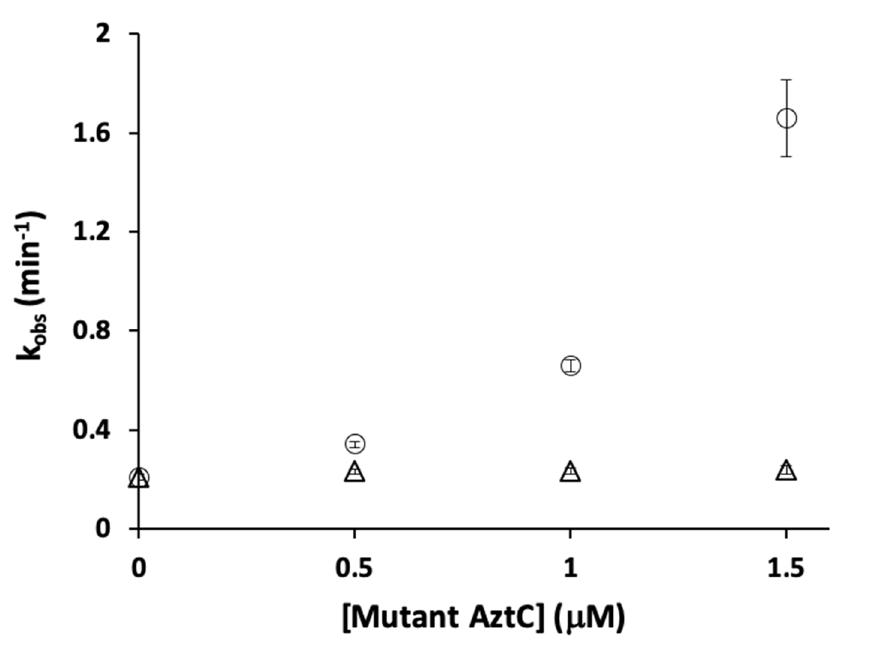
Figure 7. Kinetics of zinc transfer from WT AztD to WT AztC in the presence of mutant AztC. Observed first order rate constant versus H138 / 204A (circles) or ∆ D-Loop (triangles) AztC concentration. WT AztC and AztD were both present at 0.5 µ M, EDTA was present at 1 mM. Error bars represent standard deviations from triplicate experiments (n = 3).